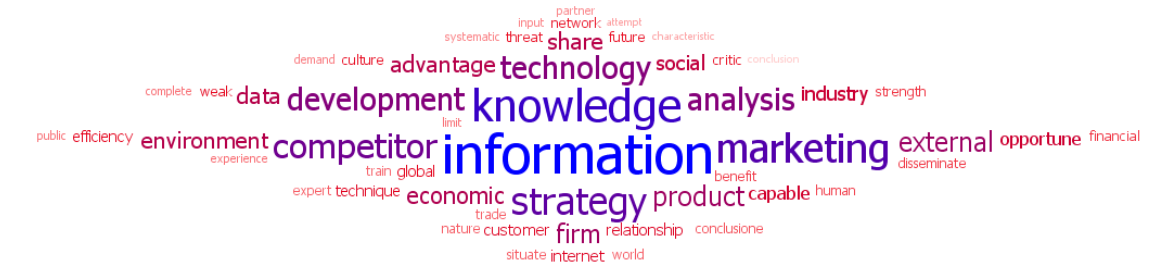
Figure 5. Word cloud of fourth